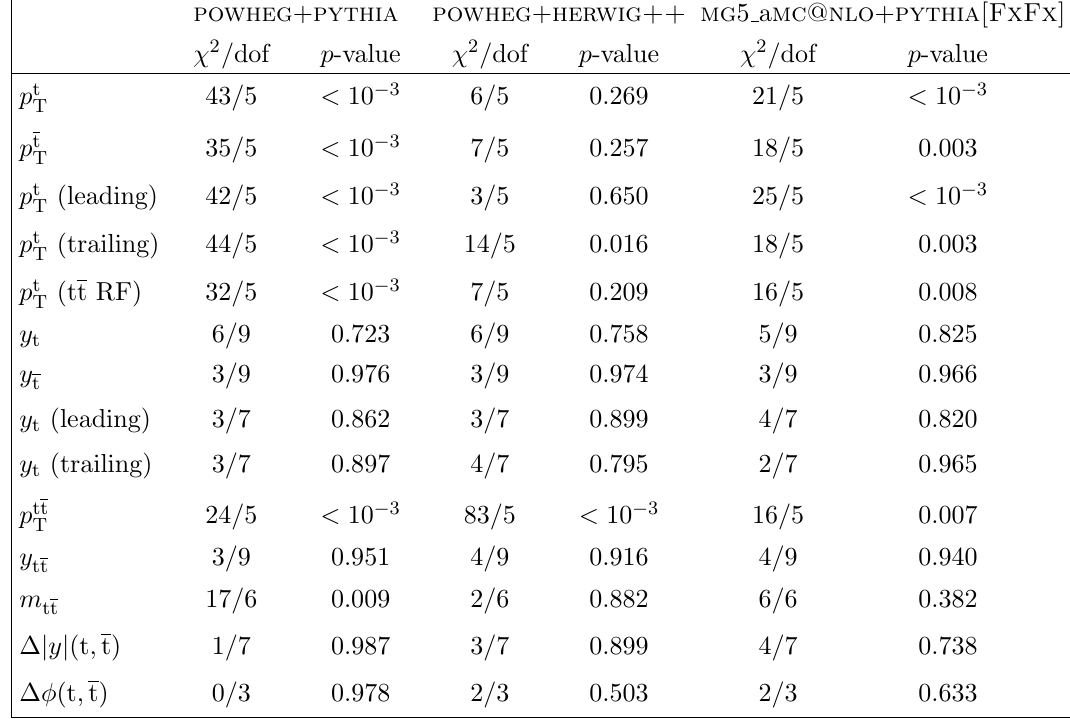
Table 48 . The (cid:31) 2 /dof and p -values quantifying the agreement between the three MC predictions and the measured, parton-level normalised cross sections are